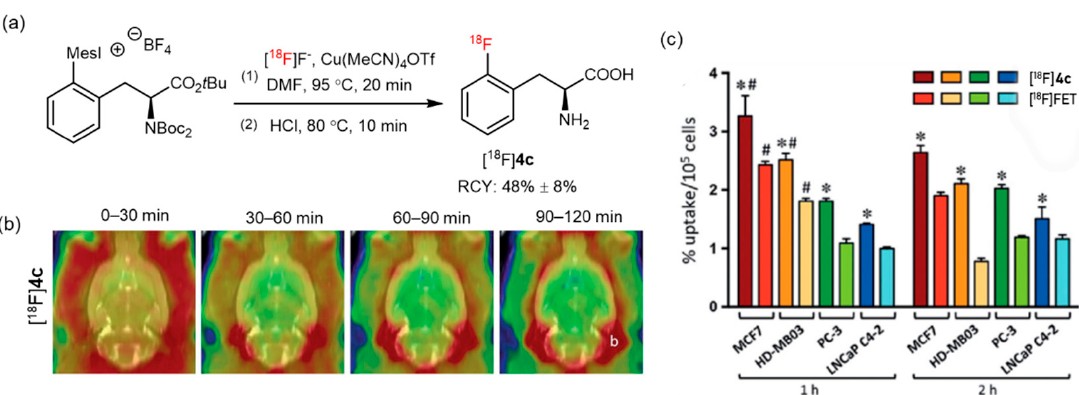
Figure 5. ( a ) Radiosynthesis of [ 18 F] 4c from an iodonium salt precursor. Modified from Modemann